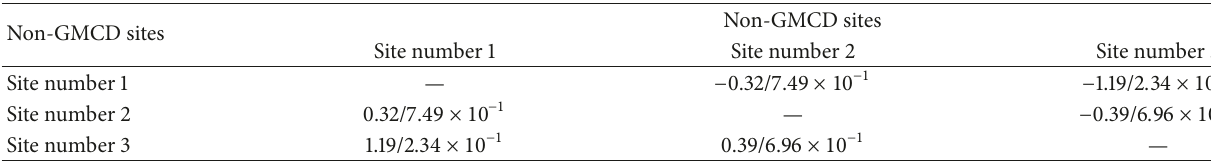
Table 3: Calculated 𝑧 -values/ 𝑝 values of behavior indicators among non-GMCD sites. (a) Proportions of pedestrians starting to cross with more than 20s